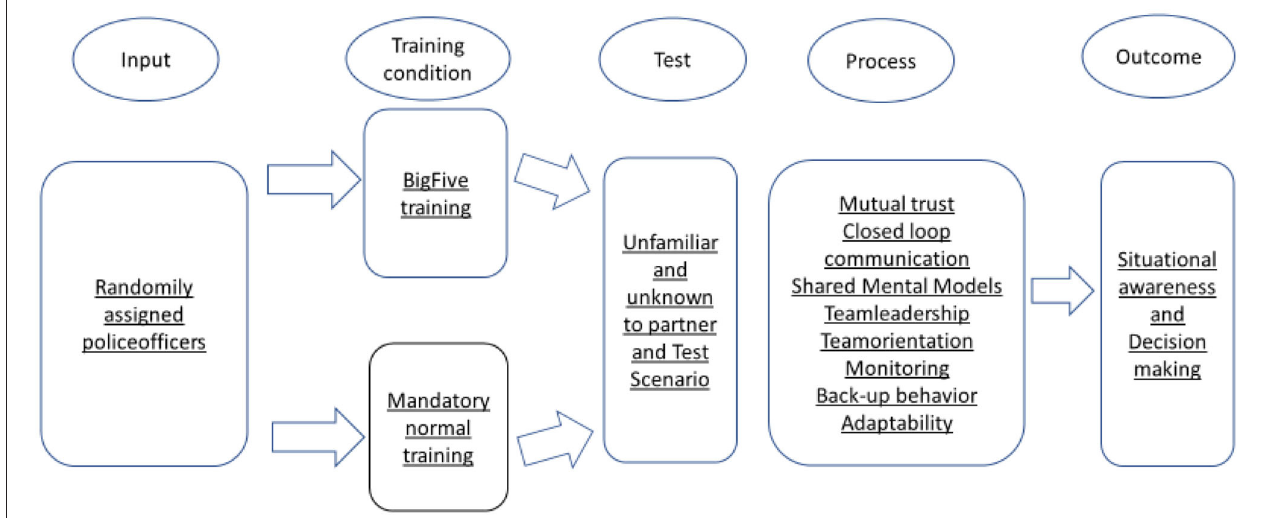
FIGURE 2 | Graphical representation of the research process using a Input-Process-Outcome